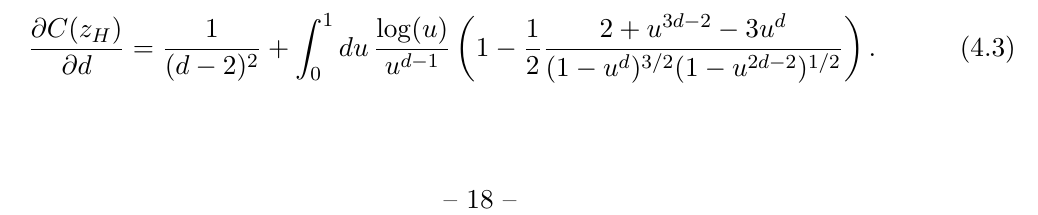
Figure 5. The ED, (cid:27) , in units of entropy density, s , versus LT for (a) the strip and (b) the sphere, for AdS-SCH in d = 4 (orange dashed) and d = 8 (blue solid). The dotted lines are 1 (cid:0) (cid:1) (cid:11) (cid:1) (cid:11) in eq. (2.23), representing the LT ! 1 limit and (cid:12)rst 1 =L correction. the dotted lines reveal that the transition between (cid:27) ! s (cid:6) as L ! 1 occurs when the coe(cid:14)cient (cid:0) (cid:1) (cid:11) of the 1 =L correction changes sign, from (cid:0) (cid:1) (cid:11) < 0 for d = 4 to (cid:0) (cid:1) (cid:11) > 0 for d =